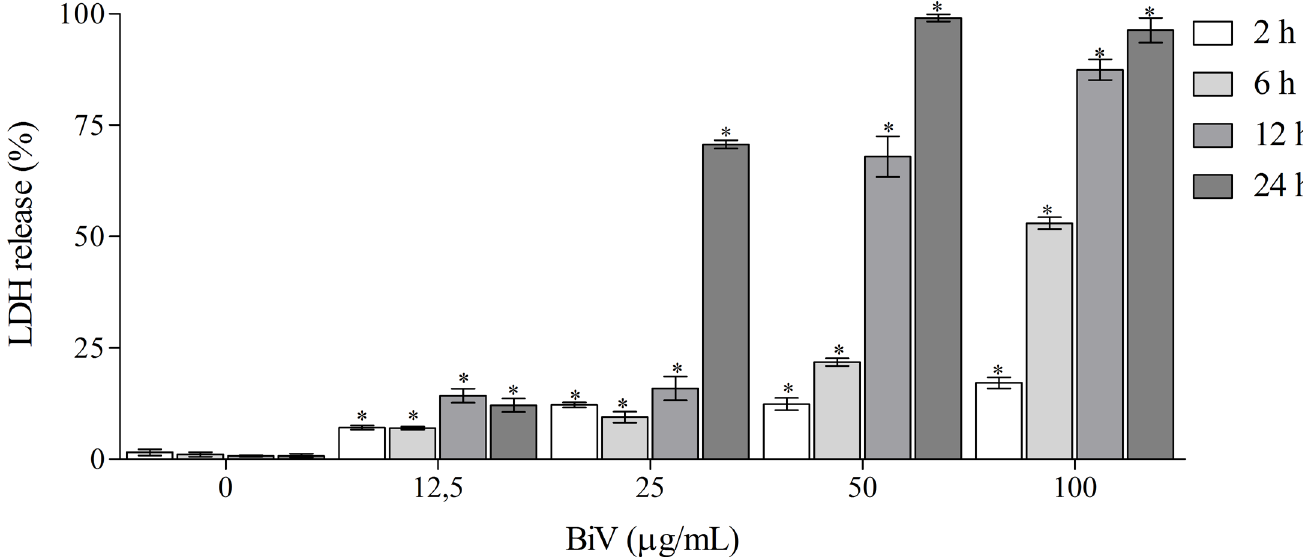
Fig 4. LDH release in macrophages treated with BiV. The percentage of enzymatic release was calculated using a group treated with 1% Triton X-100 as total cell lysis control (data not shown). * p < 0.05 vs. negative control